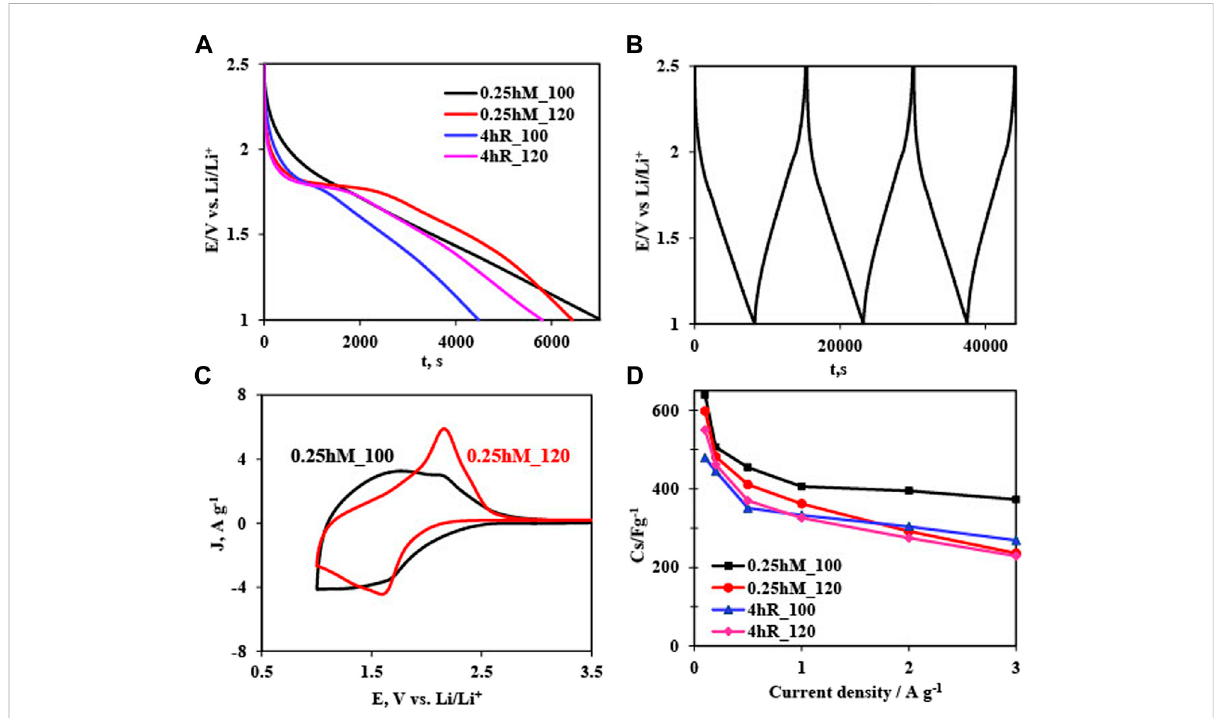
FIGURE 5 Electrochemical characterization of TiO 2 materials using LiPF 6 EC/PC/3DMC electrolyte: (A) galvanostatic discharge pro fi le at a charge density of 0.1 A g − 1 , (B) galvanostatic charge ‒ discharge pro fi le on 0.25hM_100 TiO 2 at a charge density of 0.1 A g − 1 , (C) Cyclic voltammetry at 2 mV s − 1